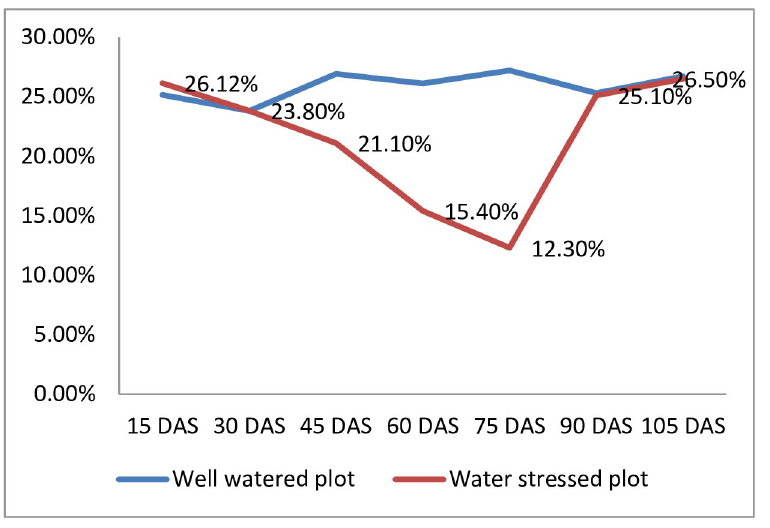
Fig 1. Moisture status in the experimental